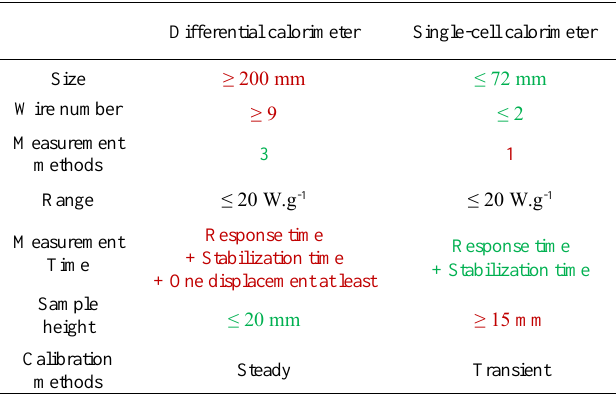
TABLE I: A DVANTAGES IN GREEN AND D RAWBACKS IN RED OF TWO HEAT - FLOW CALORIMETER FAMILIES Differential